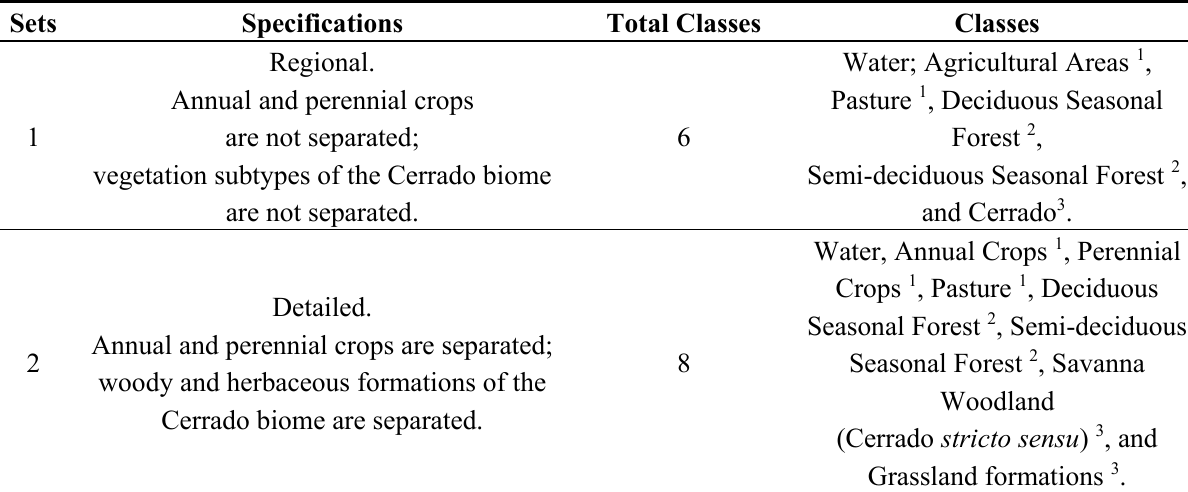
Table 2. Classes of land use and land cover used in the classification of MODIS-NDVI time-series